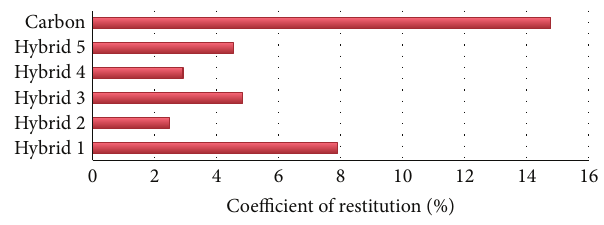
Figure 11: Percentage change of the